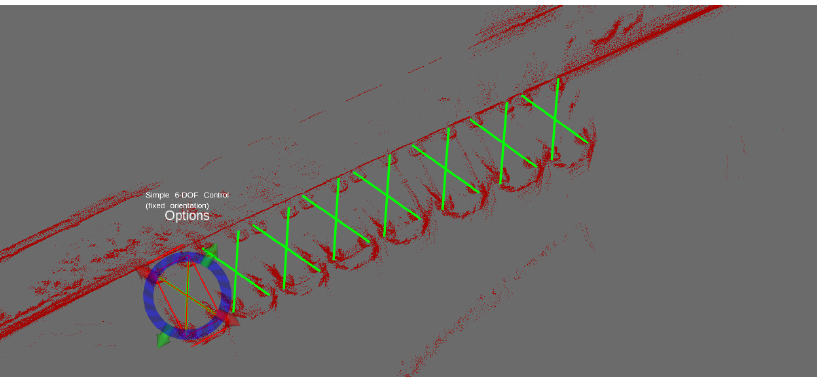
Figure 2. For collecting the ground-truth data, we developed an extension for the ROS RViz program. The laser scans were accumulated on top of each other, and then the real positions of the cars were marked by hand. A second phase, not shown, of annotating the ground truth took the frames individually and allowed the annotators to toggle whether the car was visible at that moment or not.